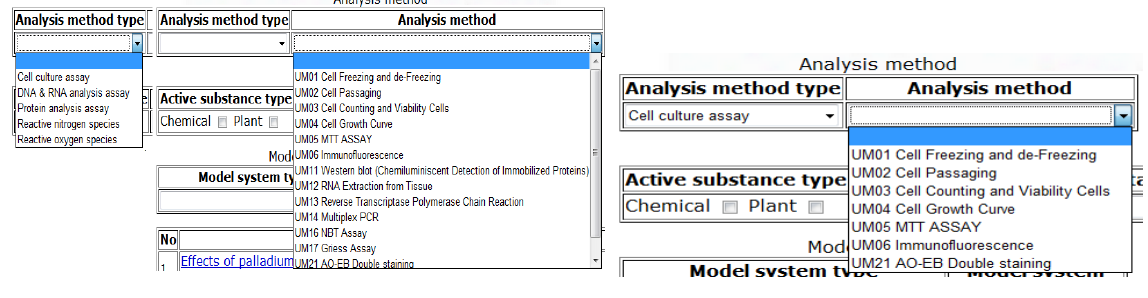
Figure 9. Analysis method